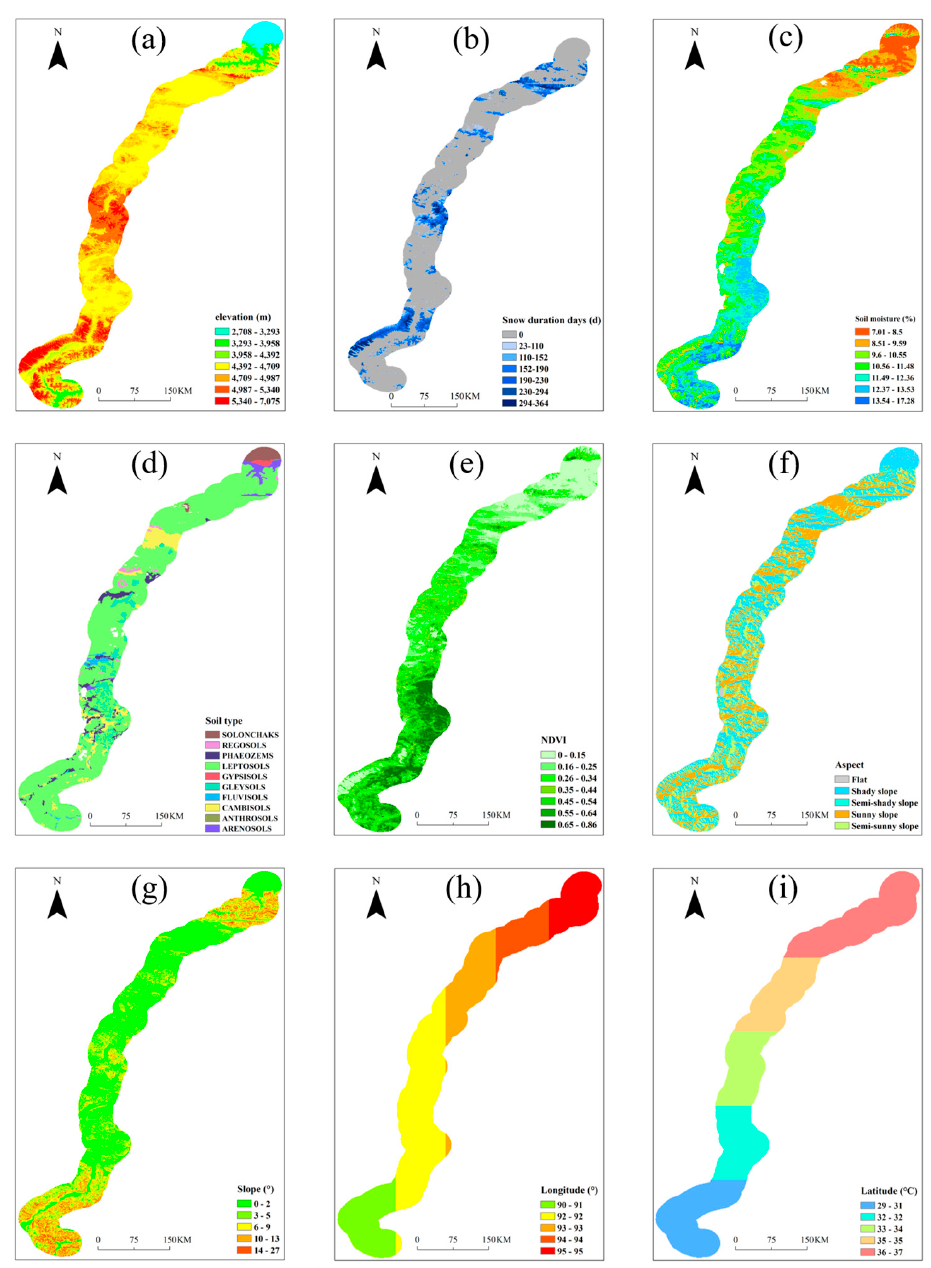
Figure 5. Distribution of the 9 environmental factors in the QTEC after classification: ( a ) elevation, ( b ) snow duration days, ( c ) soil moisture, ( d ) soil type, ( e ) NDVI, ( f ) aspect, ( g ) slope, ( h ) longitude, and ( i ) latitude.